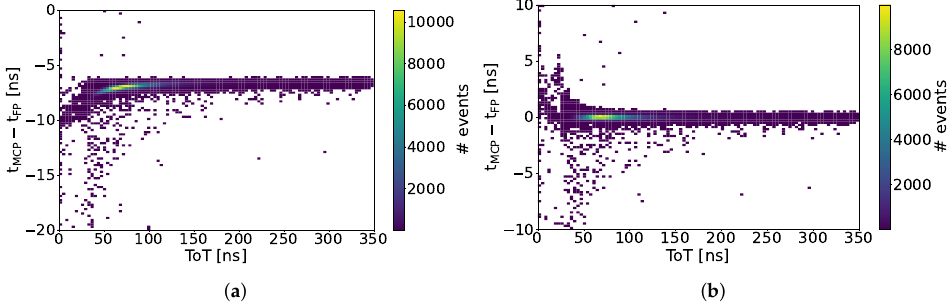
Figure 13. Seed-pixel time residuals as function of ToT for all pixels in the inner region of the 20µm pitch matrix before ( a ) and after timewalk correction ( b ).